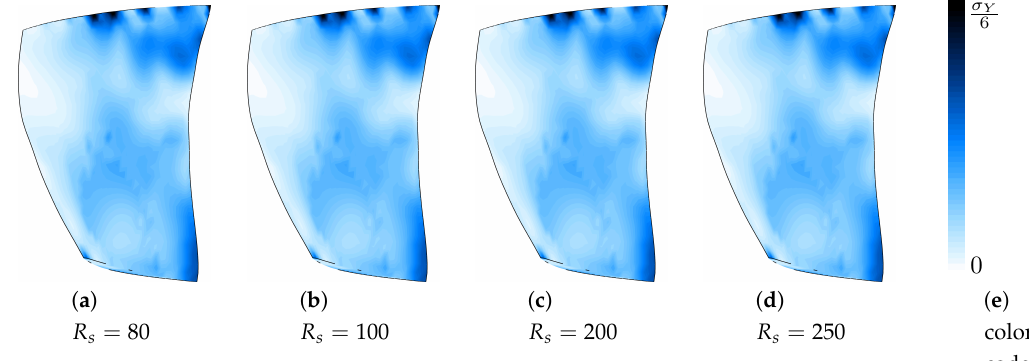
Figure 8. Blade stress fields for different R s